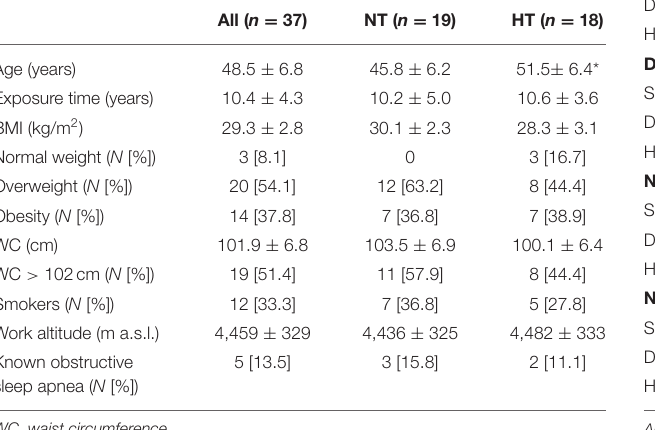
TABLE 1 | Demographic, anthropometric, and clinical characteristics of all subjects and by groups (NT and HT).